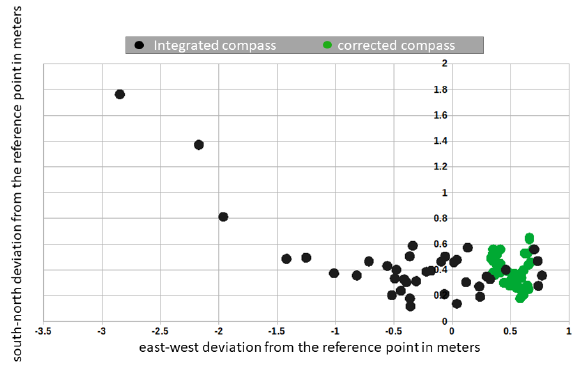
Figure 8. Site: 1, Direction: 1, Distance: 10m, Device: Samsung S10e